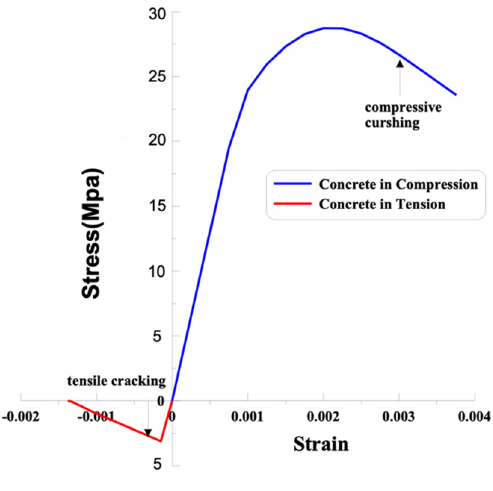
Figure 2. Stress–strain relationship of the buried concrete pipe considered in this study. Figure 2. Stress – strain relationship of the buried concrete pipe considered in this study.